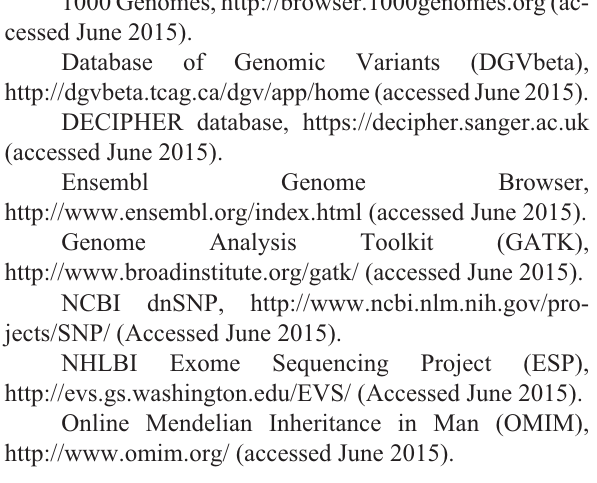
Table S2 - Genes deleted in the patient according to the NCBI Map Viewer Annotation Release 105. Table S3 - Deleted genes in our patient associated with Mendelian disease phenotypes in